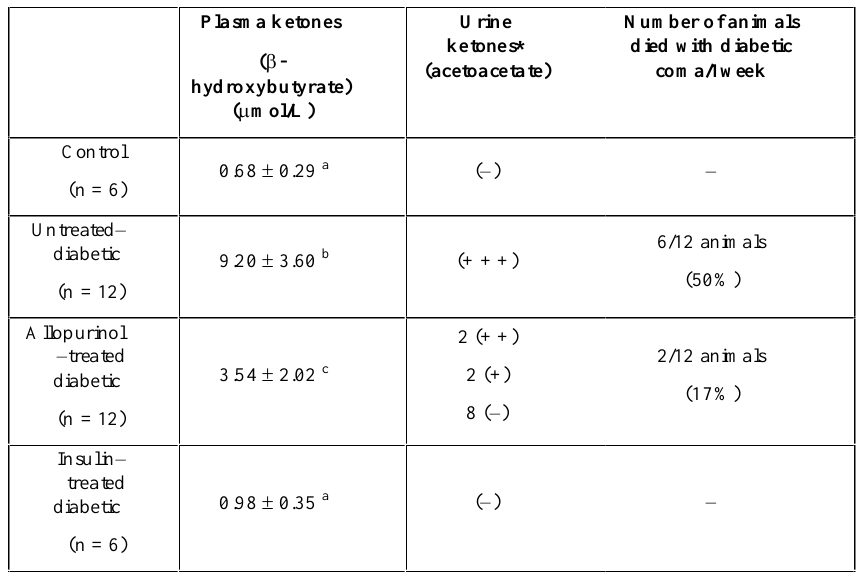
Table 1: Plasma and urine ketone body levels and mortality rate in control, untreated –